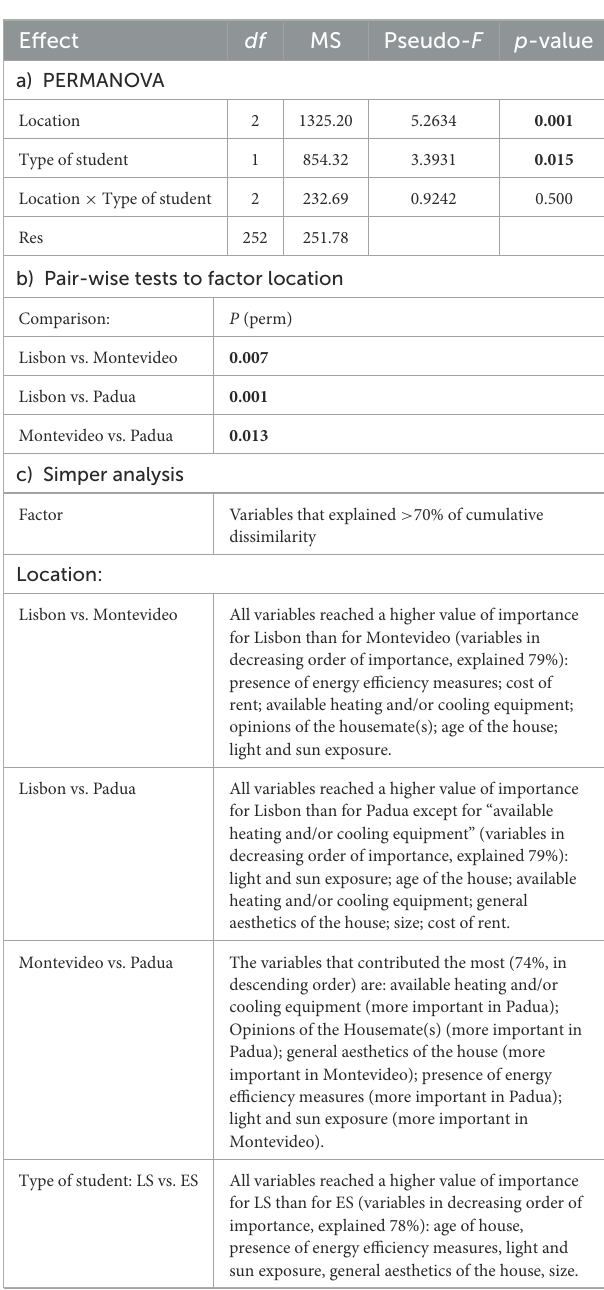
TABLE 3 (a) PERMANOVA analysis of factors location (Montevideo, Lisbon, and Padua) and type of student [local (LS) and exchange (ES) students] on the answers to questions about house hunting choices. (b) Pair-wise tests to factor in location. (c) Simper results show the variables that explained the large majority of the differences ( > 70% of cumulative